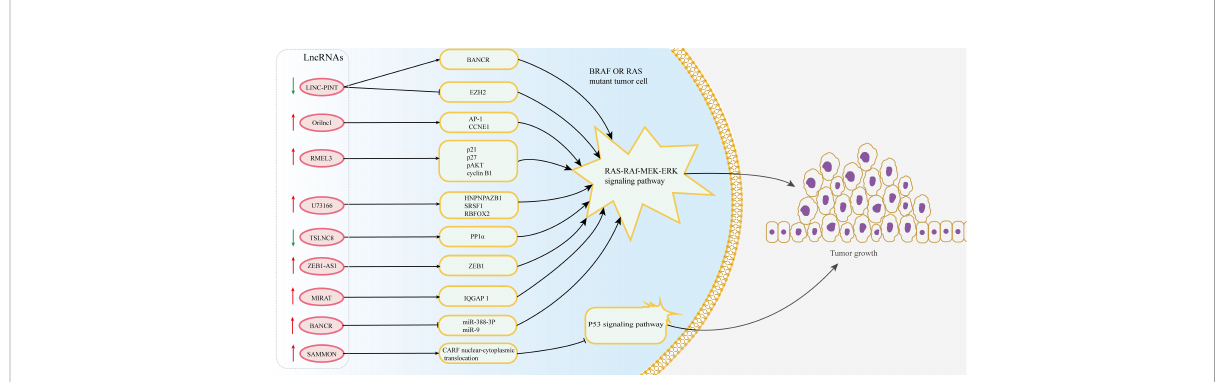
FIGURE 3 Multiple lncRNAs regulate resistance to BRAF inhibitors in melanoma. The dysregulation of lncRNAs targets the MAPK and p53 signaling pathway by regulating downstream target proteins in BRAF or RAS mutant melanoma cells, thus affecting the resistance of melanoma to BRAF